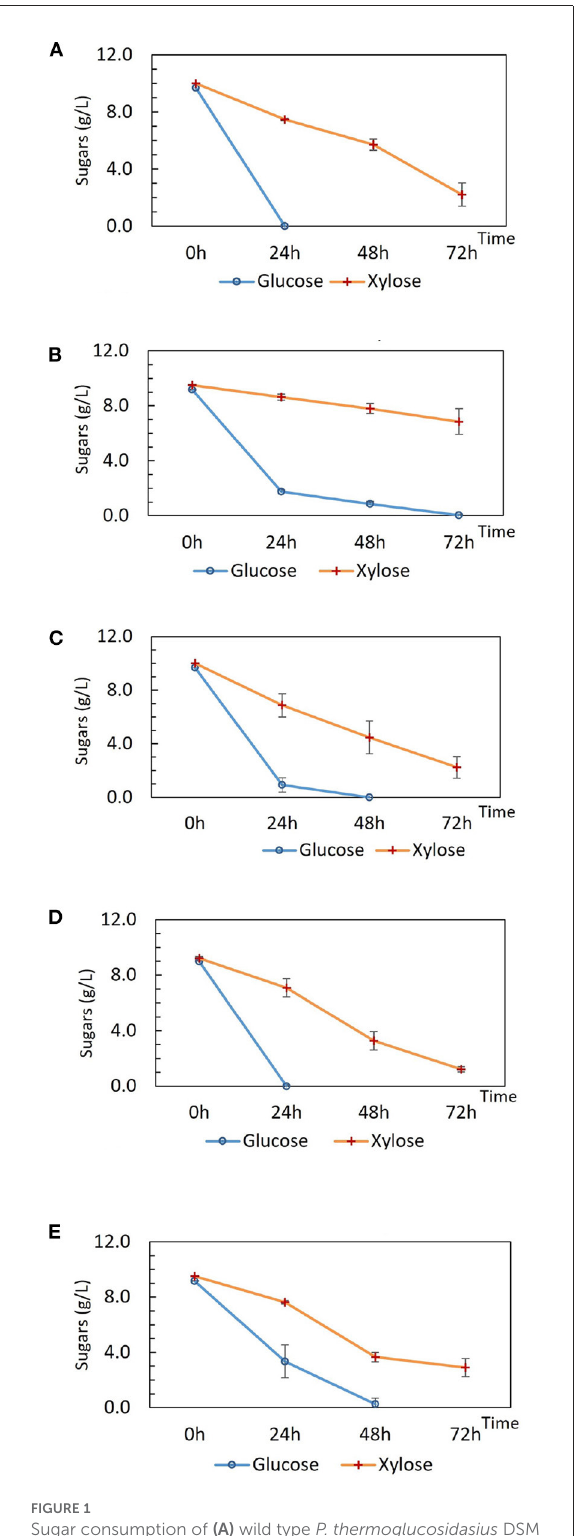
FIGURE1 Sugar consumption of (A) wild type P. thermoglucosidasius DSM 2542, (B) P. thermoglucosidasius DSM 2542 pstH1